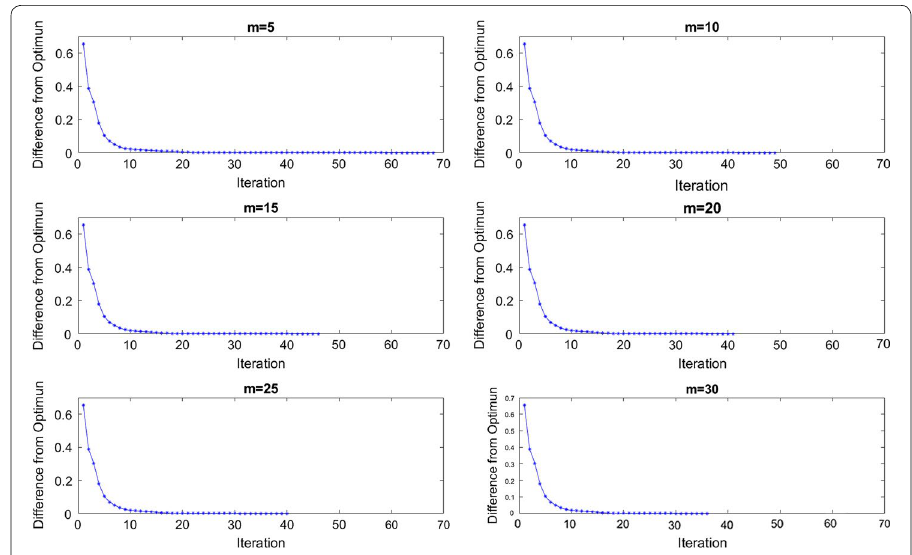
Fig. 4 L-BFGS convergence on lshtc-small dataset (λ